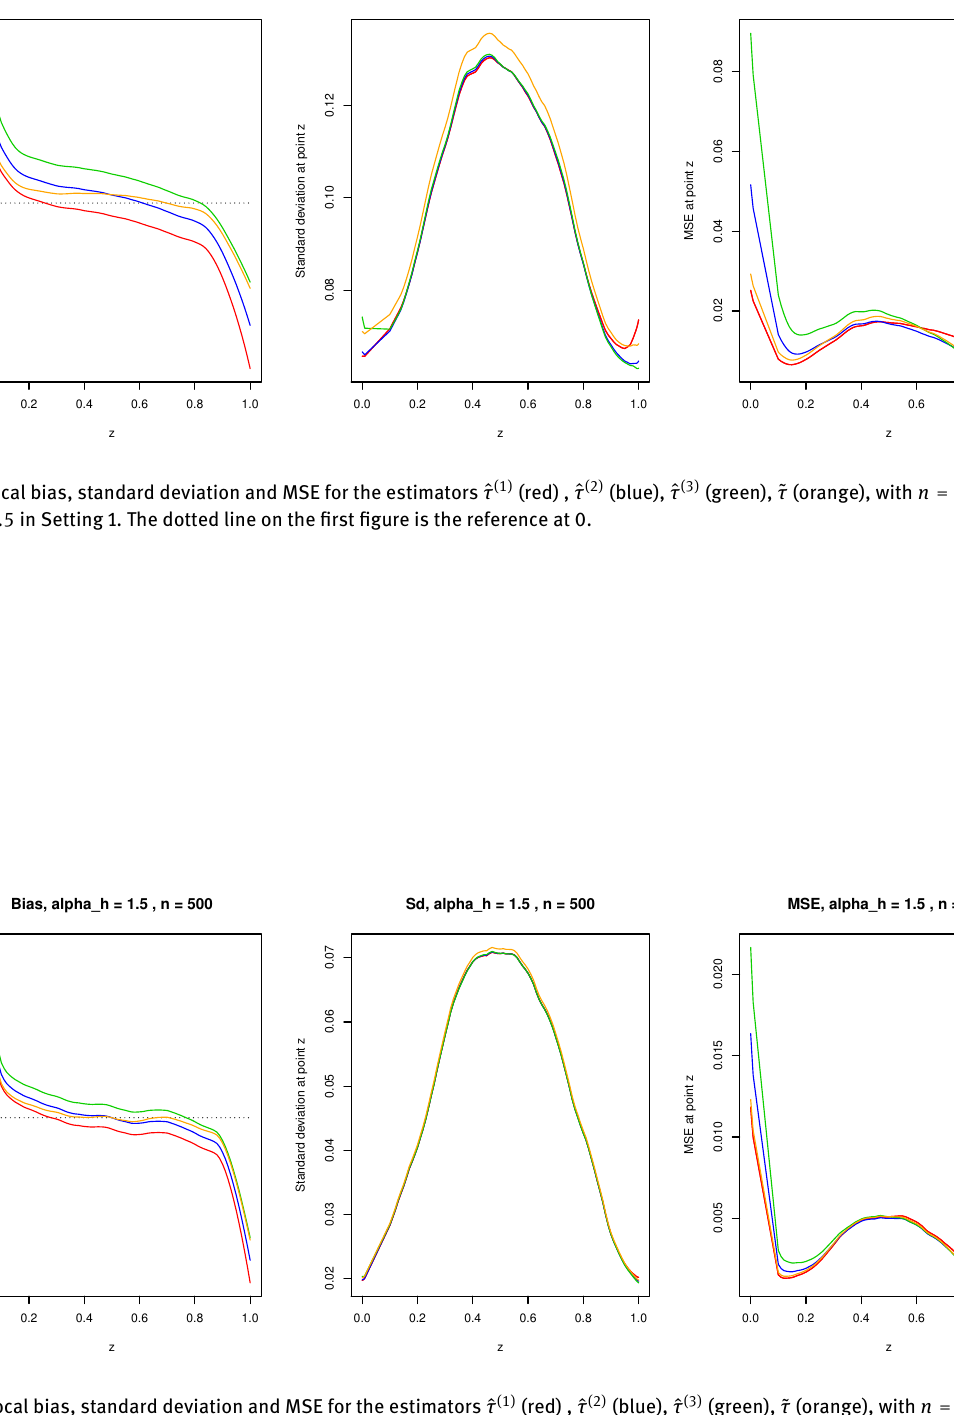
Figure 2: Local bias, standard deviation and MSE for the estimators ˆ τ (1) (red) , ˆ τ (2) (blue), ˆ τ (3) (green), ˜ τ (orange), with n = 500 and α h = 1.5 in Setting 1. The dotted line on the first figure is the reference at